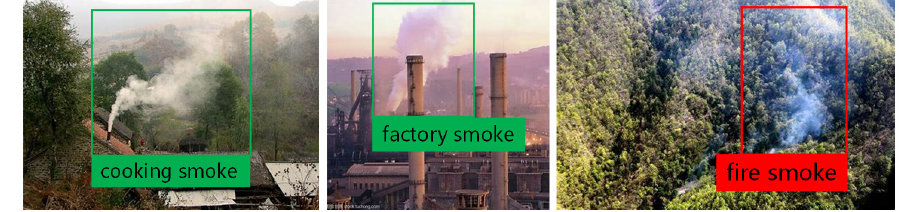
Figure 2. Fine-grained smoke identification screens out non-hazardous smoke.